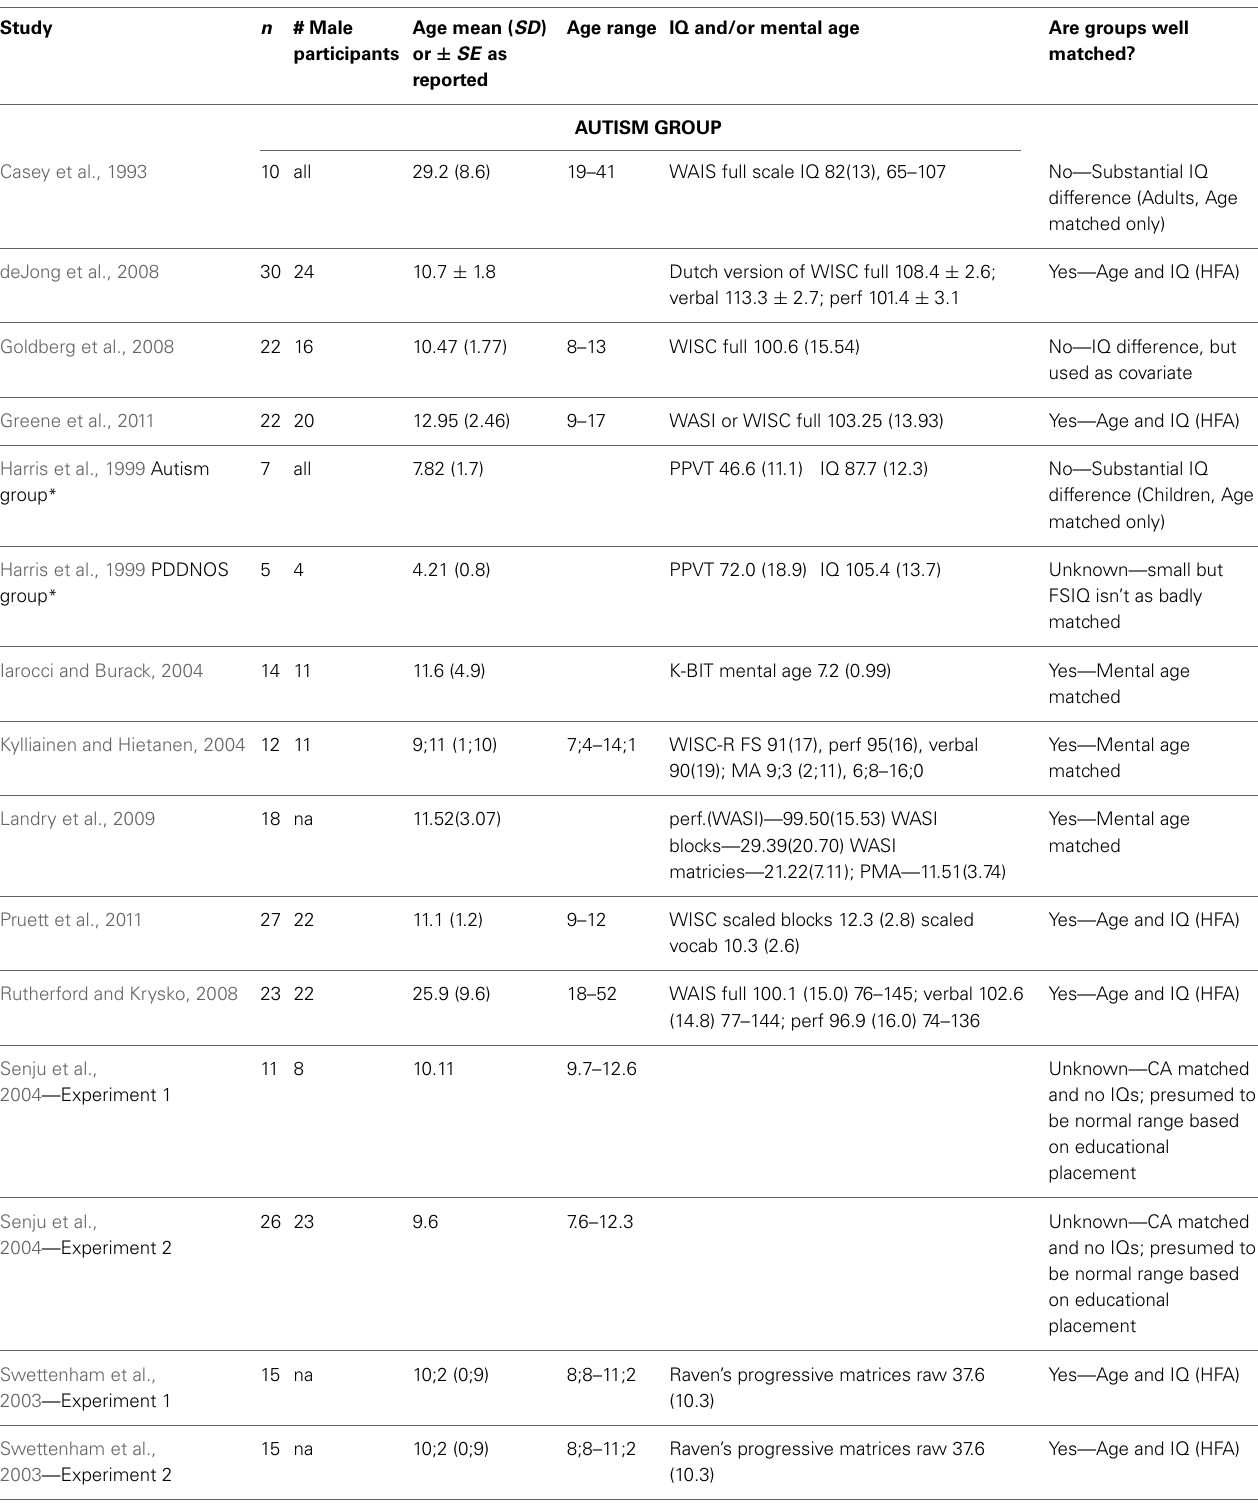
Table 2 | Age and IQ details of participants with autism and comparison